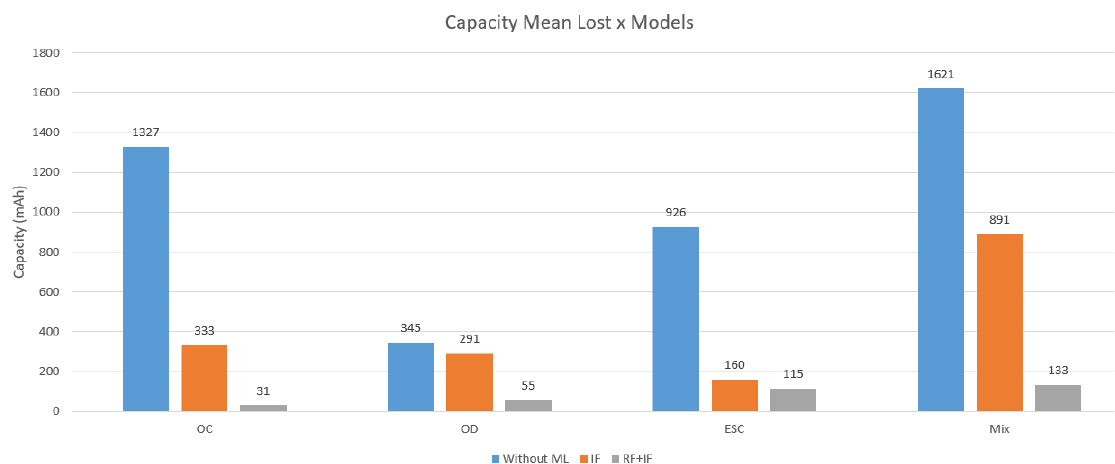
Figure 8. Mean lost capacity of the cells with and without ML. The capacity loss is high when no ML is applied. The IF could significantly reduce the capacity loss by observing only the cell’s temperature. However, the combination of the RF and IF could reduce the chances of capacity loss in the cells, according to the experiments.